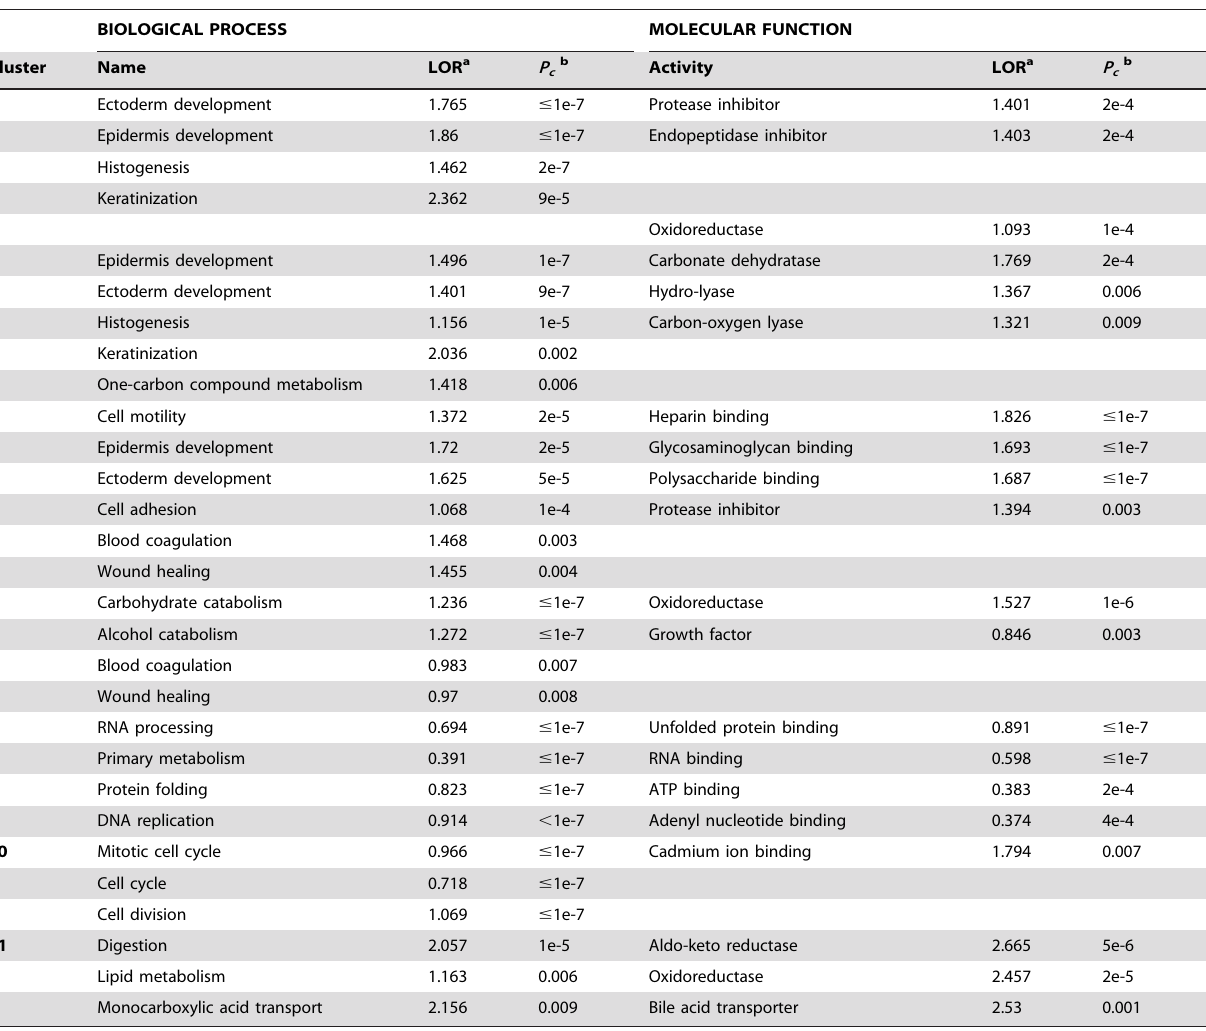
Table 1. Summary of Gene Ontology of expression clusters in differentiating